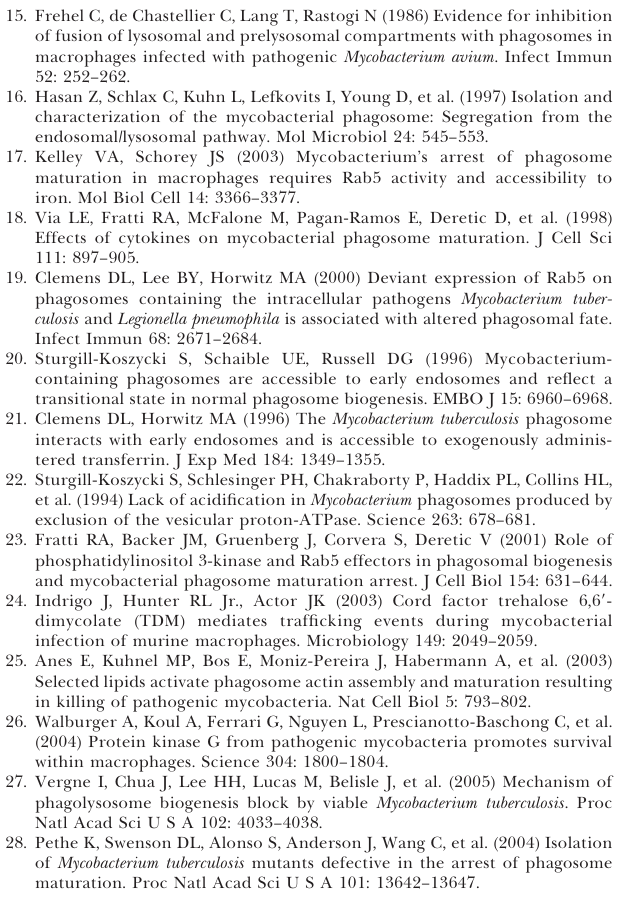
Figure S1. Reproducibility of the TSM Labelling and Genome-Wide Distribution of Transposon Insertions (A) Reproducibility of the TSM labelling and hybridisation. Hybrid- isation signal intensities were compared from two independent labelling and hybridisation operations on a 2,500-clone EZ::TN hyg insertion library. A strong correlation was observed ( r 2 ¼ 0.9289). (B) Genome-wide distribution of transposon insertions in a pool of 2,500 M. bovis BCG EZ::TNhyg mutants revealed by PCR-based TSM using an M. tuberculosis H37Rv microarray. The horizontal bar represents the genome of H37Rv with mutagenised genes represented as vertical black lines. Three of the BCG deletion regions are indicated by arrows along with a region of defective oligonucleotide probes that do not efficiently hybridise target DNAs. Figure S2. Mutants with Defects in the Inhibition of Phagosome pH